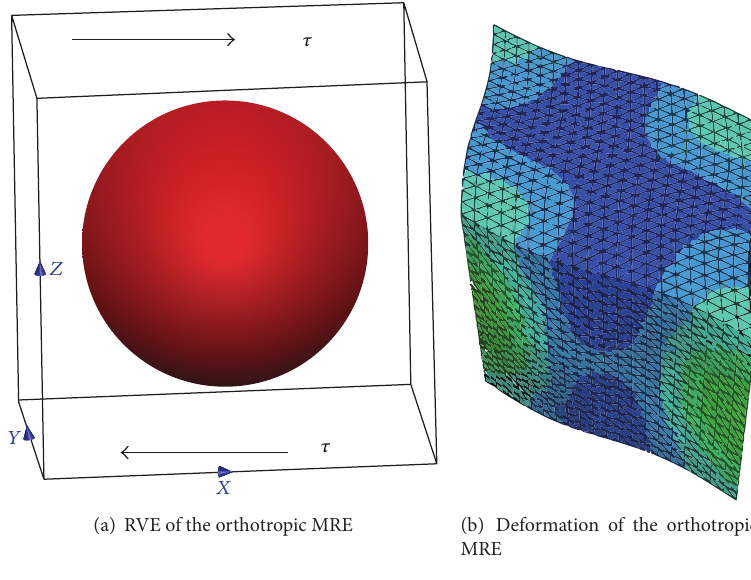
Figure 4: Orthotropic